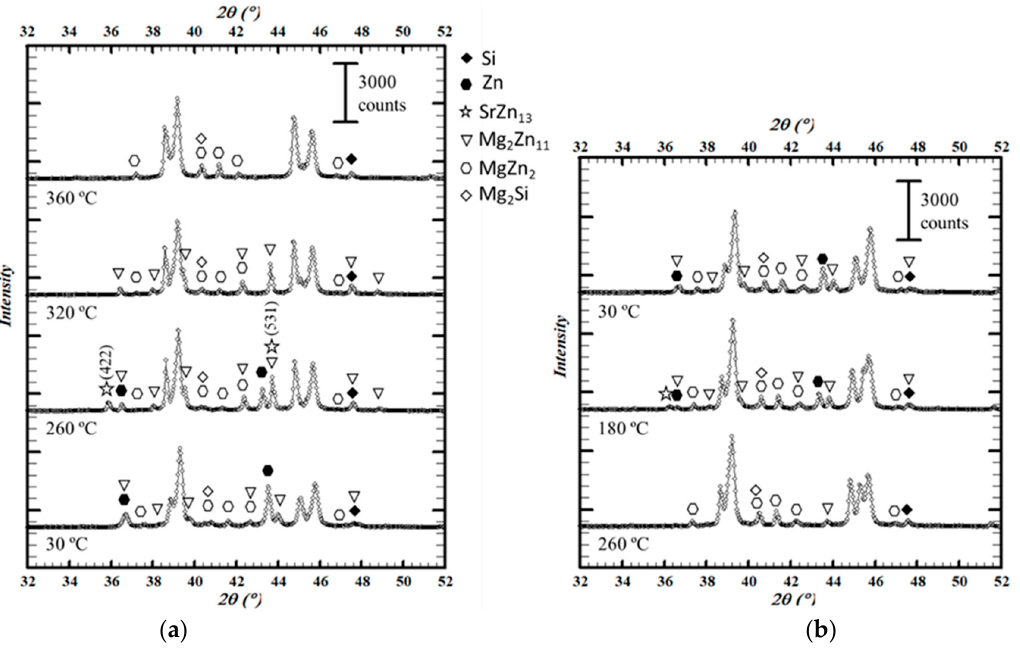
Figure 8. Diffraction patterns of the as-cast sample showing the evolution of the intermetallic phases, Zn, and Si with temperature ( a ) during the heating cycle (from 30 to 360 °C) ( b ) and cooling cycle (from 360 to 30 °C) in the thermo-diffractometer. The main Bragg peaks for the SrZn 13 phase are identified.